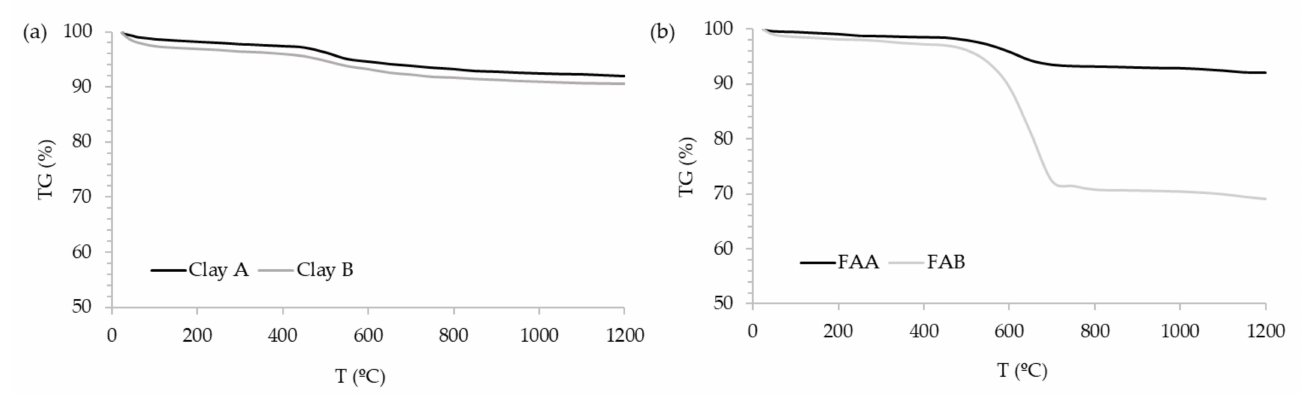
Figure 3. XRD pattern of clay A ( a ), clay B ( b ), FAA ( c ), and FAB ( d ).